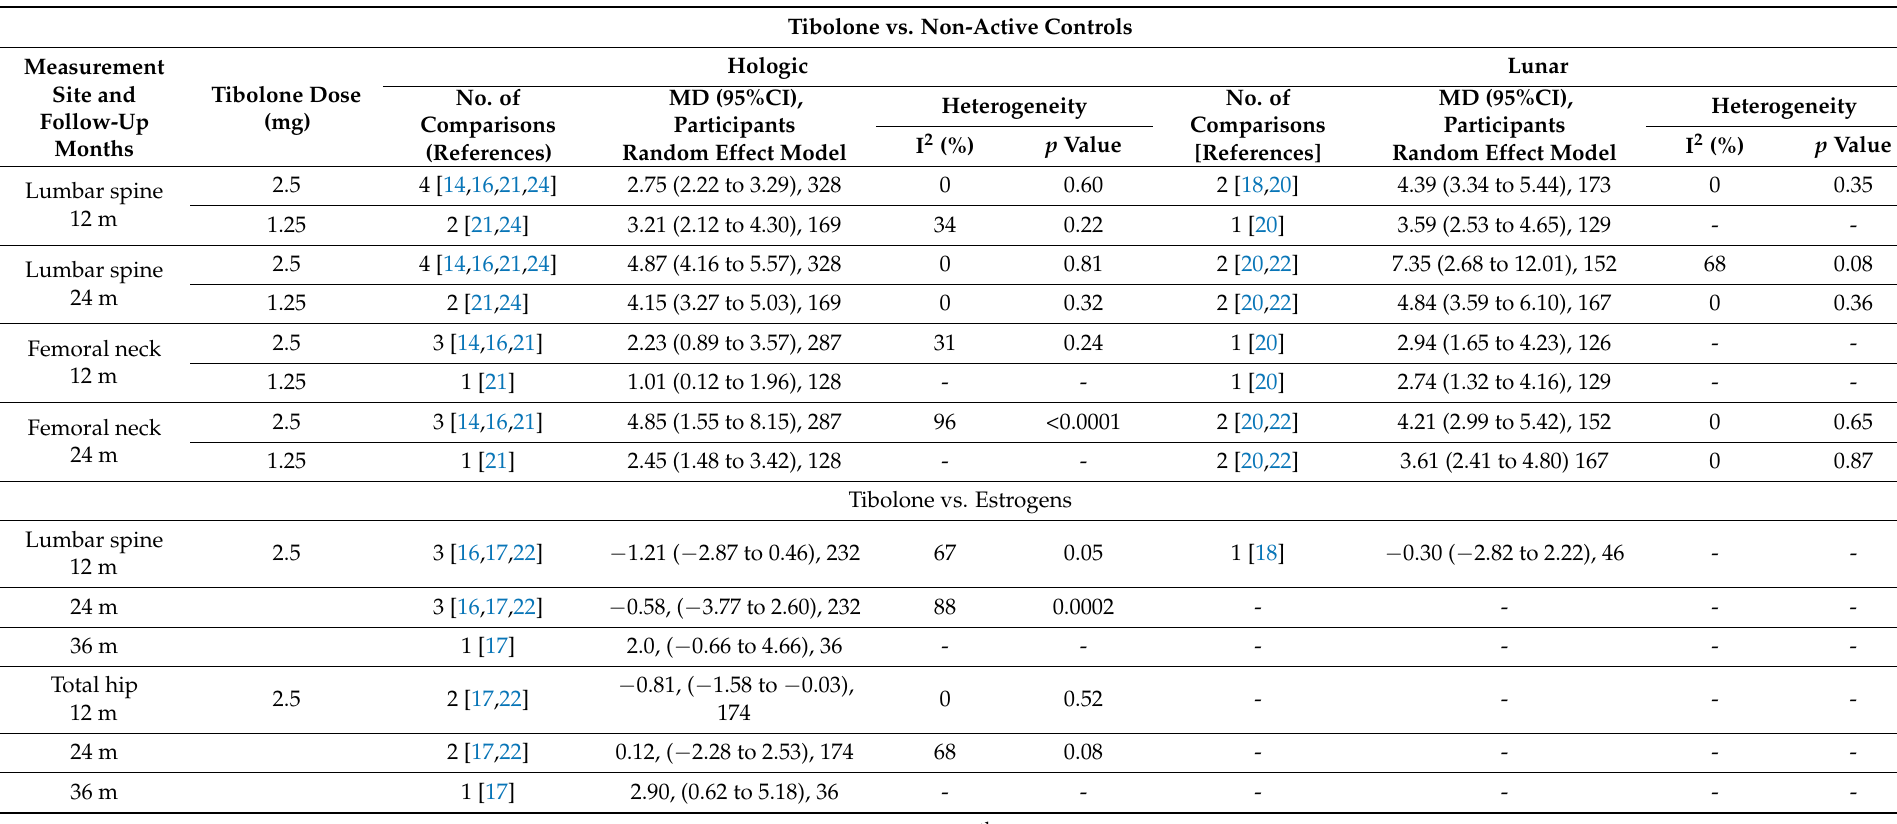
Table 2. Results of the meta-analysis of the mean difference in percentage change from the baseline in bone mineral density. MD; mean difference; 95%CI: 95% confidence interval. Tibolone vs. Non-Active